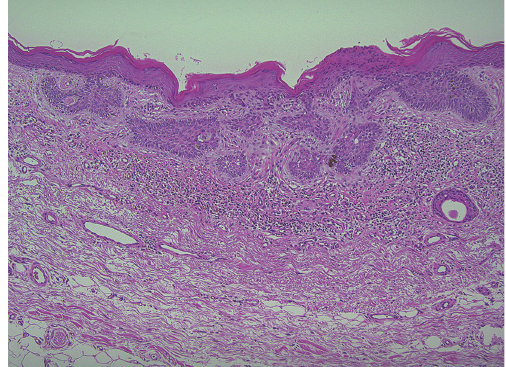
Figure 3: Microphotograph of superficial basal cell carcinoma (HE staining). The histologic characteristics of superficial BCC include buds and irregular proliferations of tumor cells attached to atrophic epidermis.